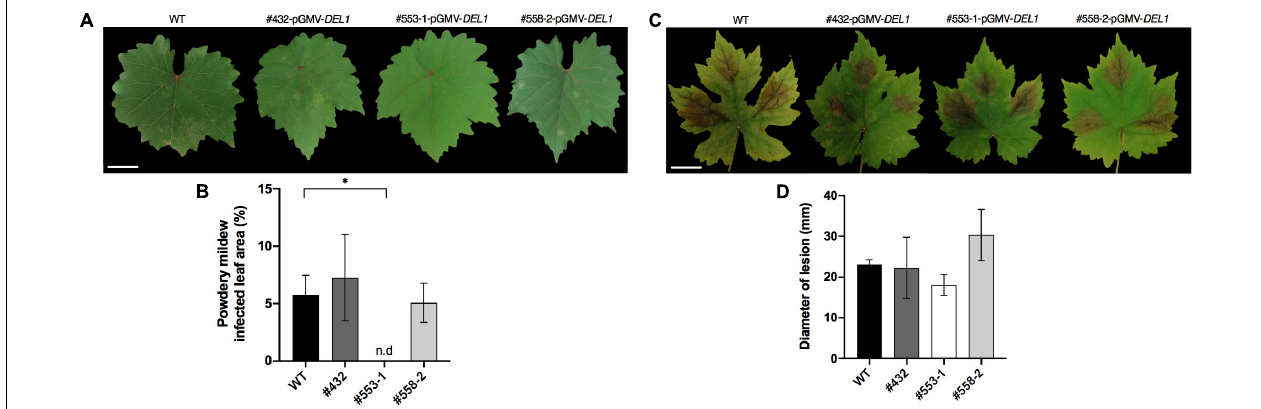
FIGURE 5 | Prospective behavior of edited individuals under fungal challenge. Plants released into the greenhouse were primarily observed for their response to fungal challenge under natural (oidium) and controlled ( Botrytis ) conditions. Vines were arranged in a single block including the 19 double-cut edited vines and six wild type (WT) individuals randomly allocated in the block. Powdery mildew natural infection in this location was established by tagging and scoring of three fully developed leaves per plant over 14 days since first E. necator symptoms were first detected (A) ; responses found in a selected line are then compared (B) . Leaf materials from the same individuals in the block were collected and assayed for B. cinerea infection using conidia suspensions and controlled fungal growing conditions in humidity chambers in the laboratory (C) ; and responses found in some events from the group are depicted (D) . In this latter, 10 µ L aliquots at 10 7 /mL were used, and necrotic lesions were scored 72-h post-inoculation; three biological replicates ( n = 3 leaves per plant) were performed, and data was subjected to one-way ANOVA and means separated by Fisher’s LSD test ( p < 0.05) using GraphPad Prism v8.4.3. Asterisk indicates significant differences compared to WT; n.d, non-detected. The white bar represents 3 cm.